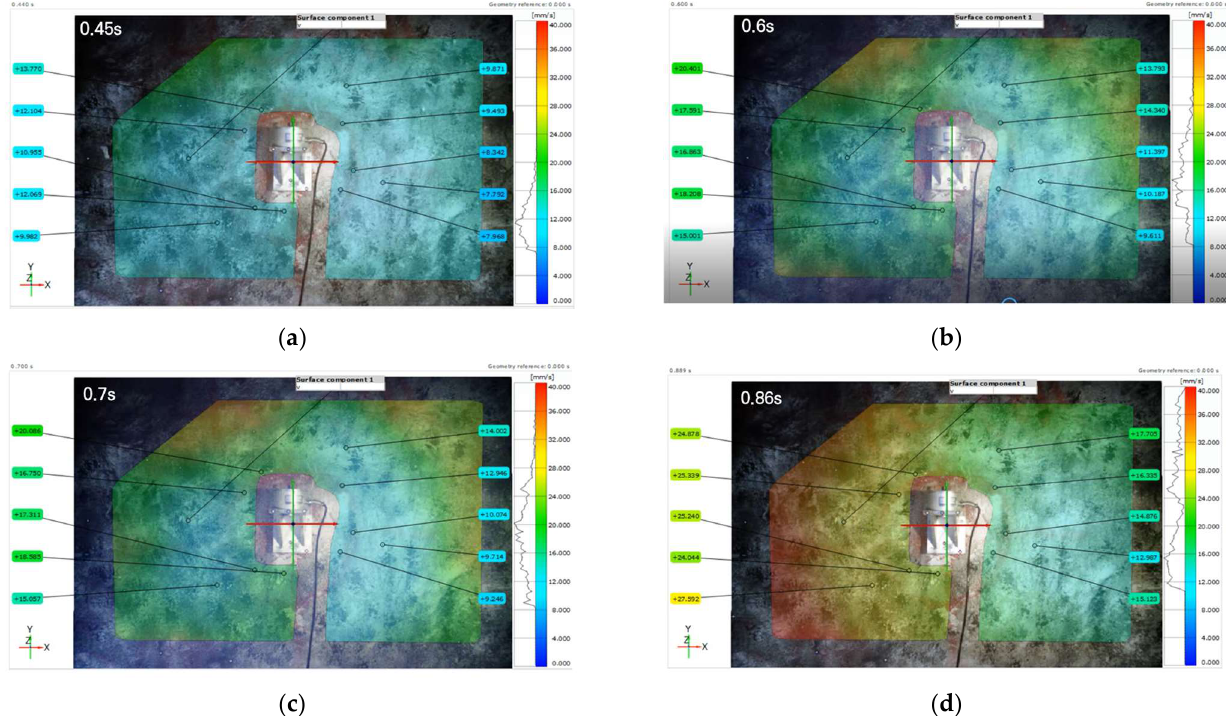
Figure 8. Vibration of rock pillars ROI at each time point after experimental blasting: ( a ) 0.45 s, ( b ) 0.6 s, ( c ) 0.7 s, and ( d ) 0.86 s.